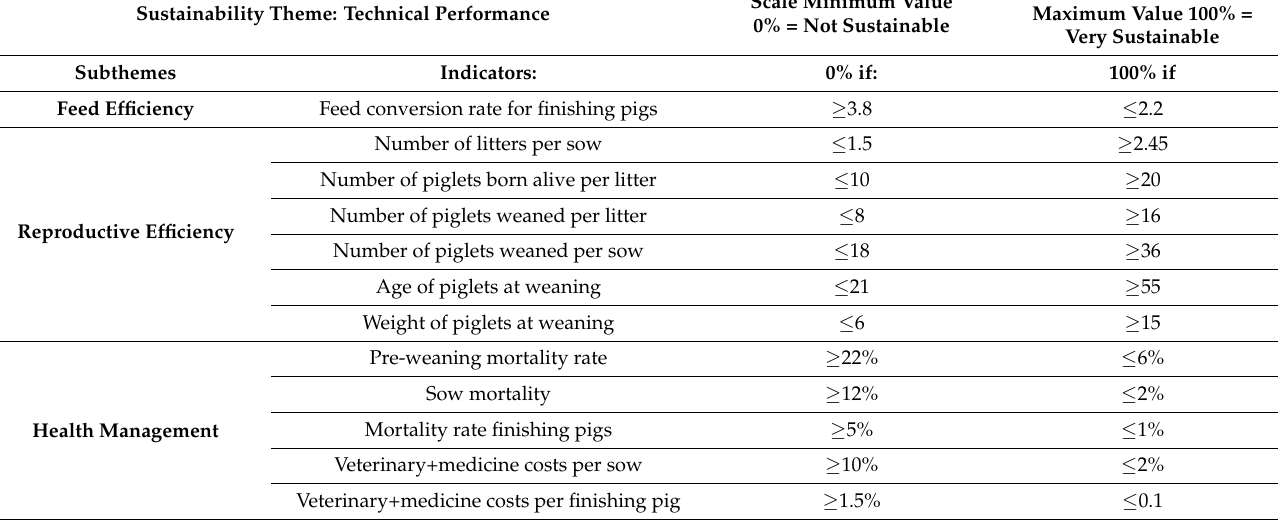
Table A1. Details of indicators under subthemes and themes of the economic sustainability of pig